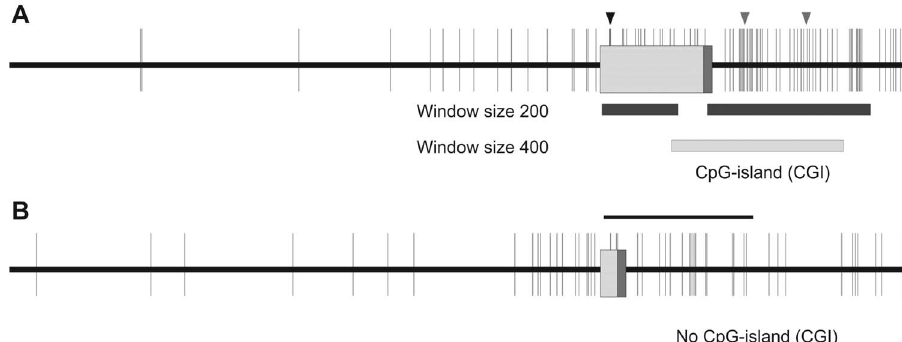
Figure 3 Schematic representation of the human FAS gene starting at -2000 to q 1000 bp (A) and the mouse Fas gene from -2000 to q 1000 bp (B) estimated from the transcription start site (TSS). Using the same settings as in Figure 2, two CGIs were found for the human (A) but not for the mouse gene (B). Increasing the